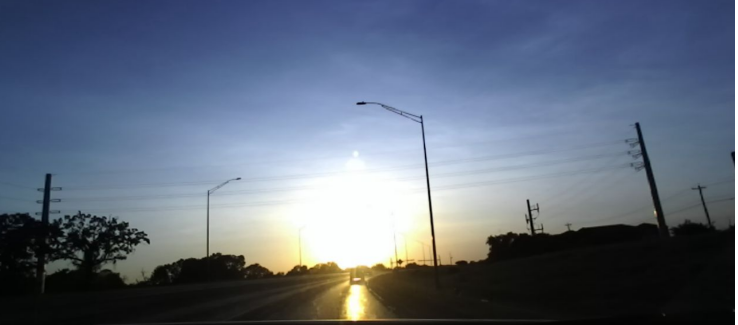
Figure 1. RGB camera hindered by direct sunlight, taken with a ZED camera from StereoLabs at 1080p resolution. Reprinted with permission from earlier conference paper Ref. [11]. ©2021, SAE